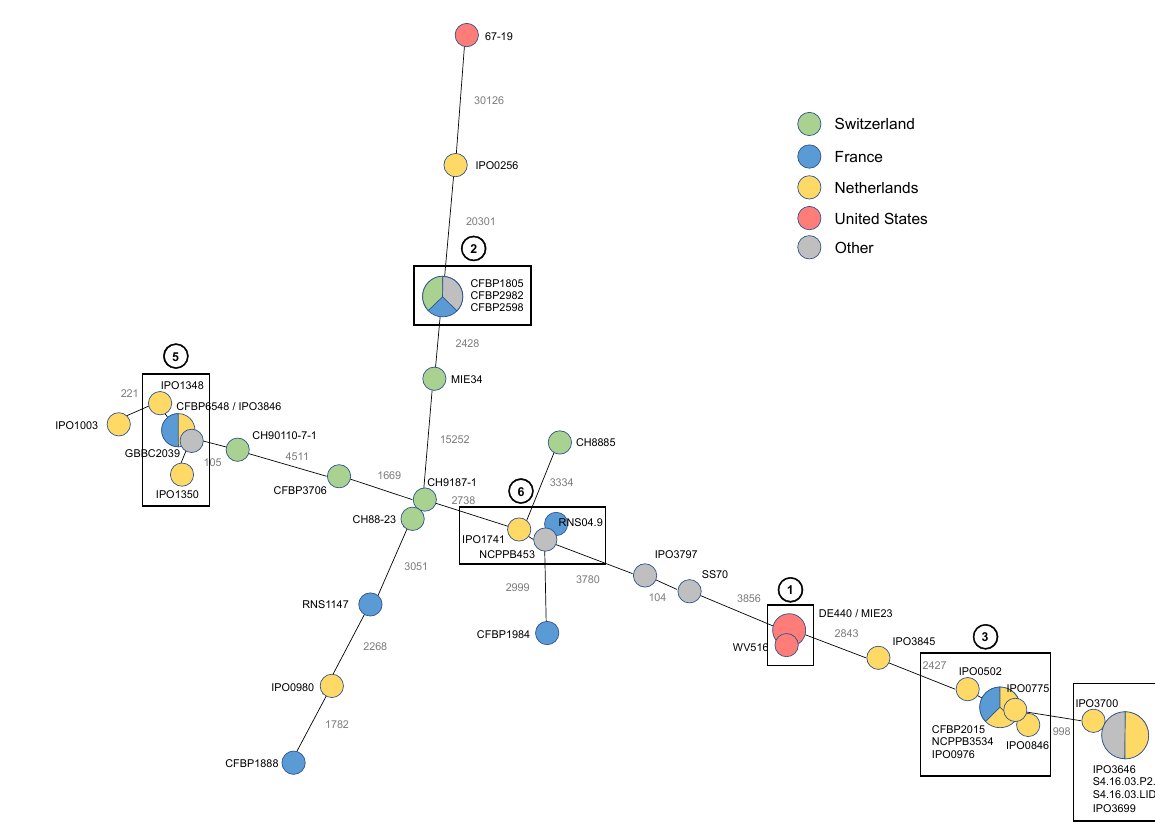
Figure 4. Minimum spanning tree based upon whole-genome SNP analysis. The tree is based upon 53,292 SNPs. The length of each branch (log scale) expressed in SNP numbers is indicated. The squares and numbers indicate the clusters of (nearly) clonal strains.